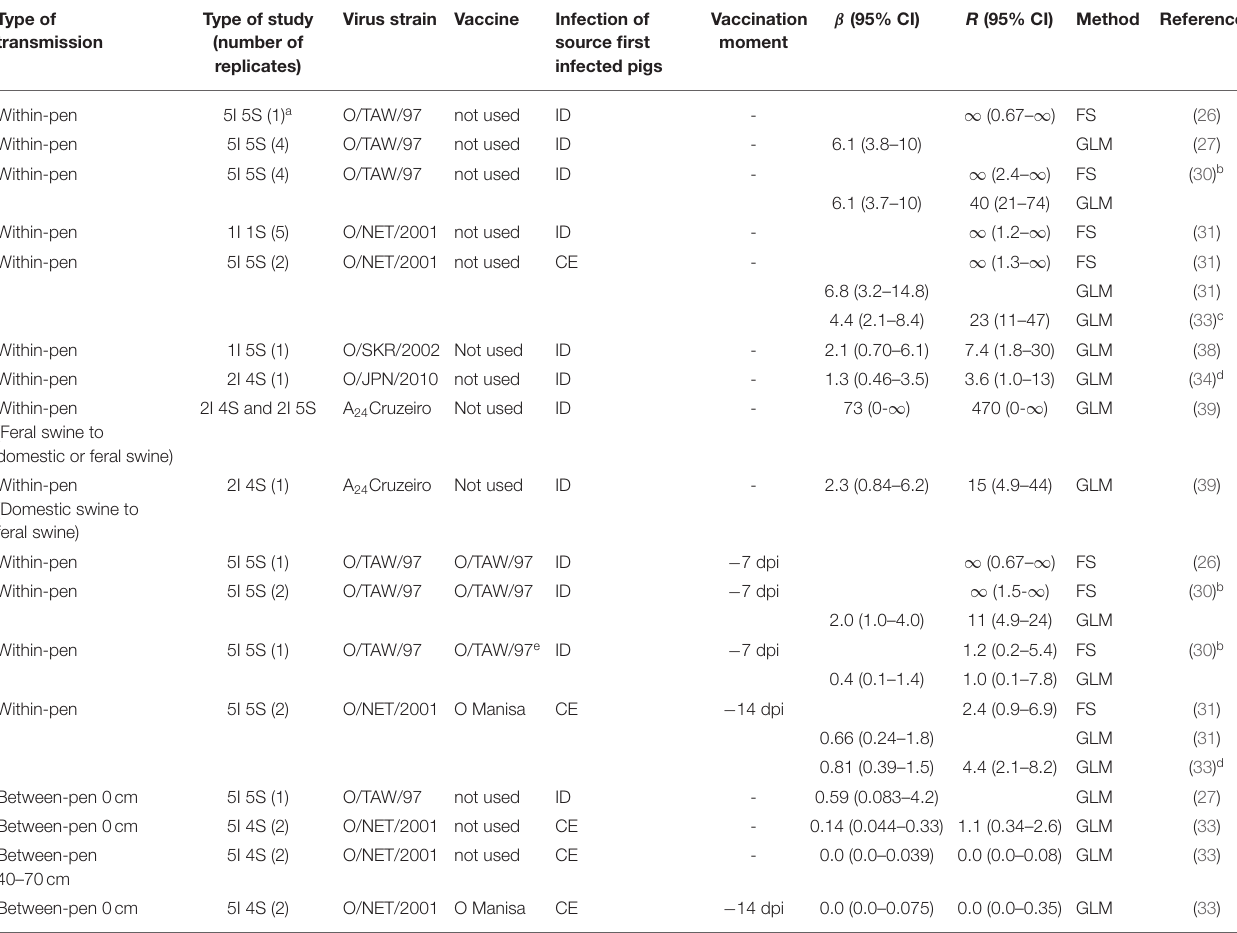
TABLE 1 | Summary of within-pen and between-pen transmission experiments with pigs. Type of